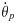
Model block diagrams.(A) Control of the pitch rate (θ˙p) in response to horizontal optic flow component (ωxRfly). The measured ωxRfly is compared with an input reference set-point, ωxRfly*, and the error (ϵω) is then sent to a Proportional-Derivative controller, which delivers a reference pitch rate, θ˙p*. We then used a second loop mimicking the halteres, to measure and adjust the pitch rate, θ˙p, to this set-point. The pitch θp obtained by integration (by definition) is then used to calculate the orientation of the thrust and the speed vector in the inertial reference frame (see B). The norm of the force produced by flapping wings is assumed to correspond to a second order transfer function with a zero based on the data. The two components of the optic flow vector in the fly reference frame, ωxRfly and ωzRfly, are then calculated geometrically (see B). ωxRfly is used to close the pitch control loop. (B) Details of the pitch rate control based on horizontal optic flow component.